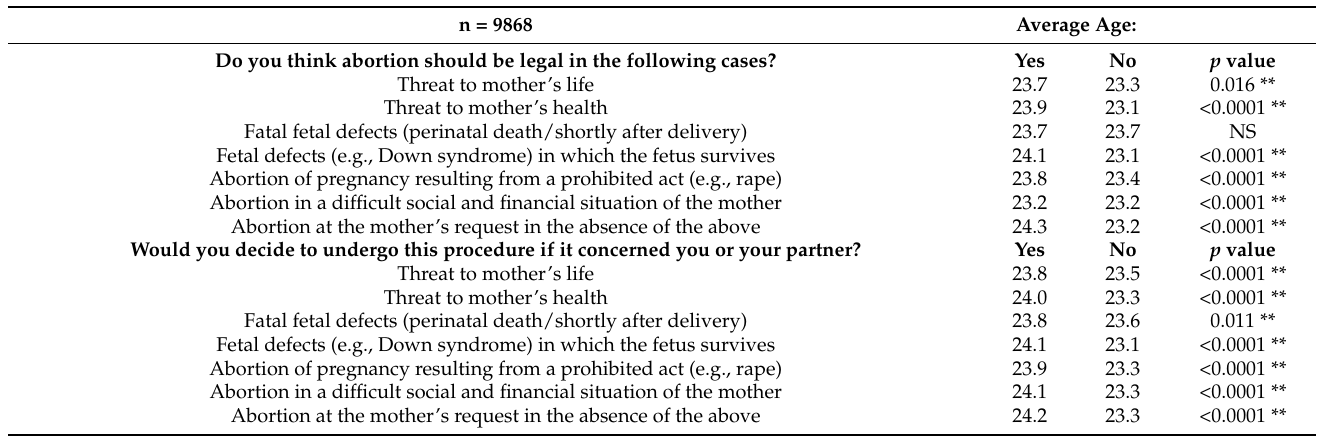
Table 5. Attitude to abortion regarding age. All data contained in table are mean age [in years] of answers adequately “YES” or “NO” in each case.